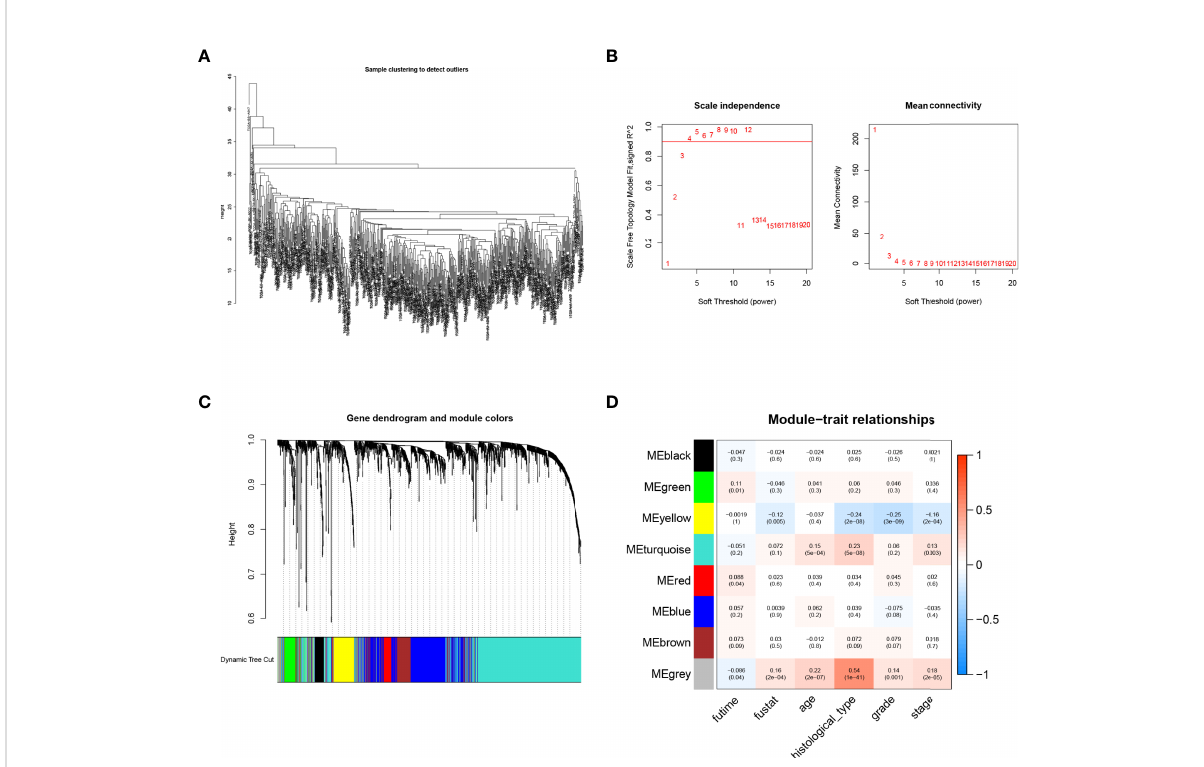
FIGURE 2 Weighted co-expression network analysis (WGCNA). (A) Sample clustering tree. (B) Soft threshold selection. As the threshold increased, the R 2 value increased and crossed 0.8. When the number of modules is 8, the model is more stable. (C, D) Distribution and correlation of each module. Through correlation analysis between different modules and phenotype (survival time and survival status), it was fi nally found that green, red, and yellow modules were signi fi cantly positively correlated with endometrial carcinoma (EC)prognosis.